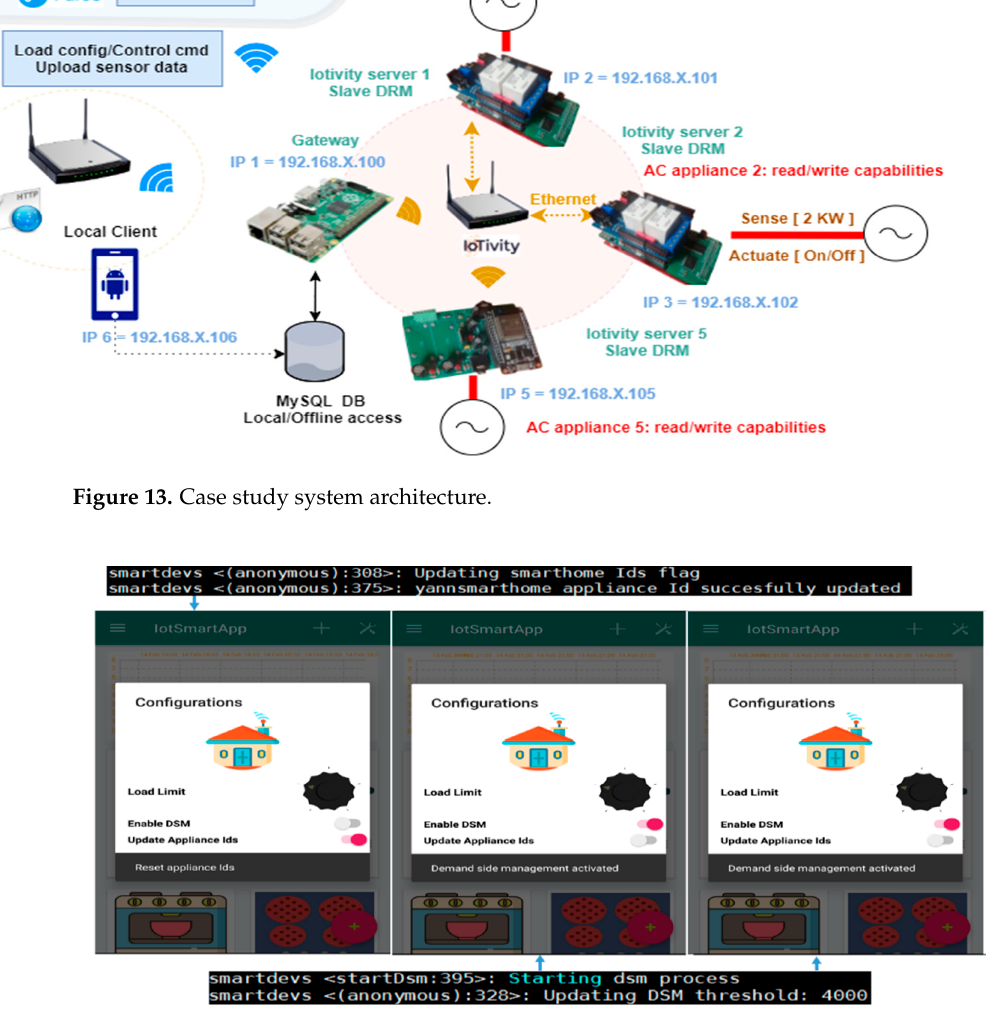
Table 2. Appliances in the considered home with their typical priority level.